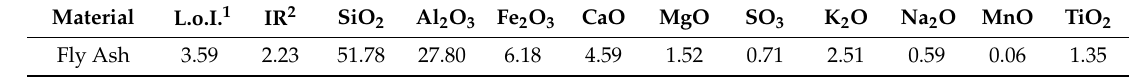
Table 1. Main oxide composition of fly ash (FA) powder.